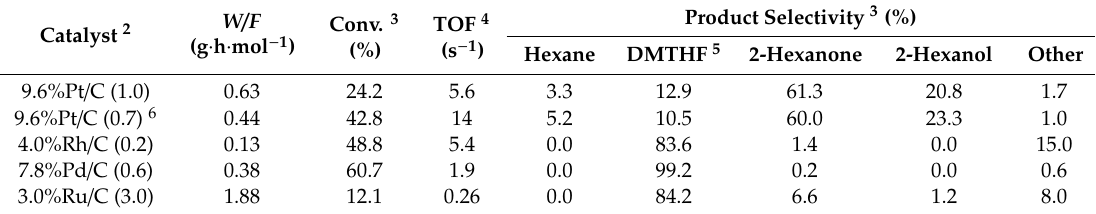
Table 2. Turnover frequencies of noble metals in DMF hydroconversion 1